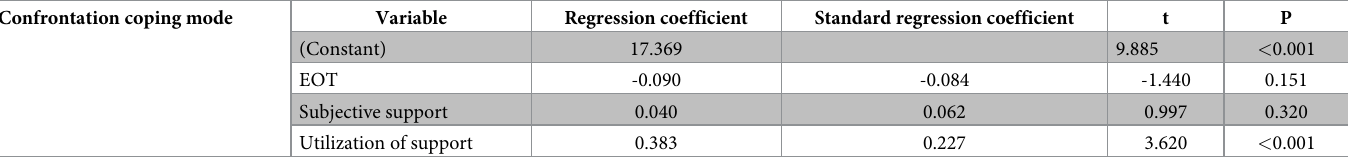
Table 7. Multivariate analysis of the confrontation coping mode among the patients treated with IVF-ET. Confrontation coping mode